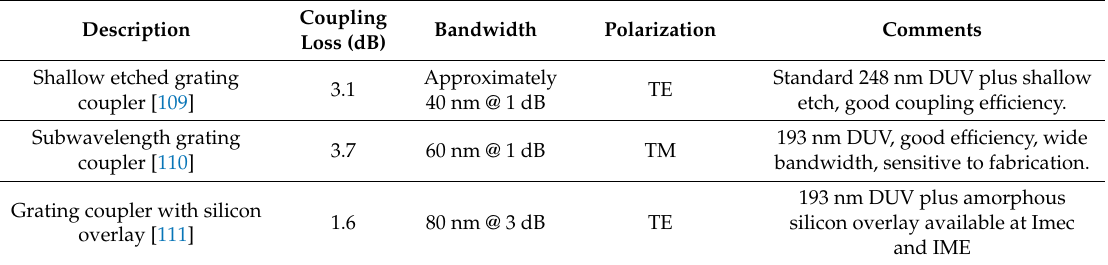
Table 2. Comparison between edge couplers and grating couplers. DUV: deep ultraviolet, EBL: electron beam